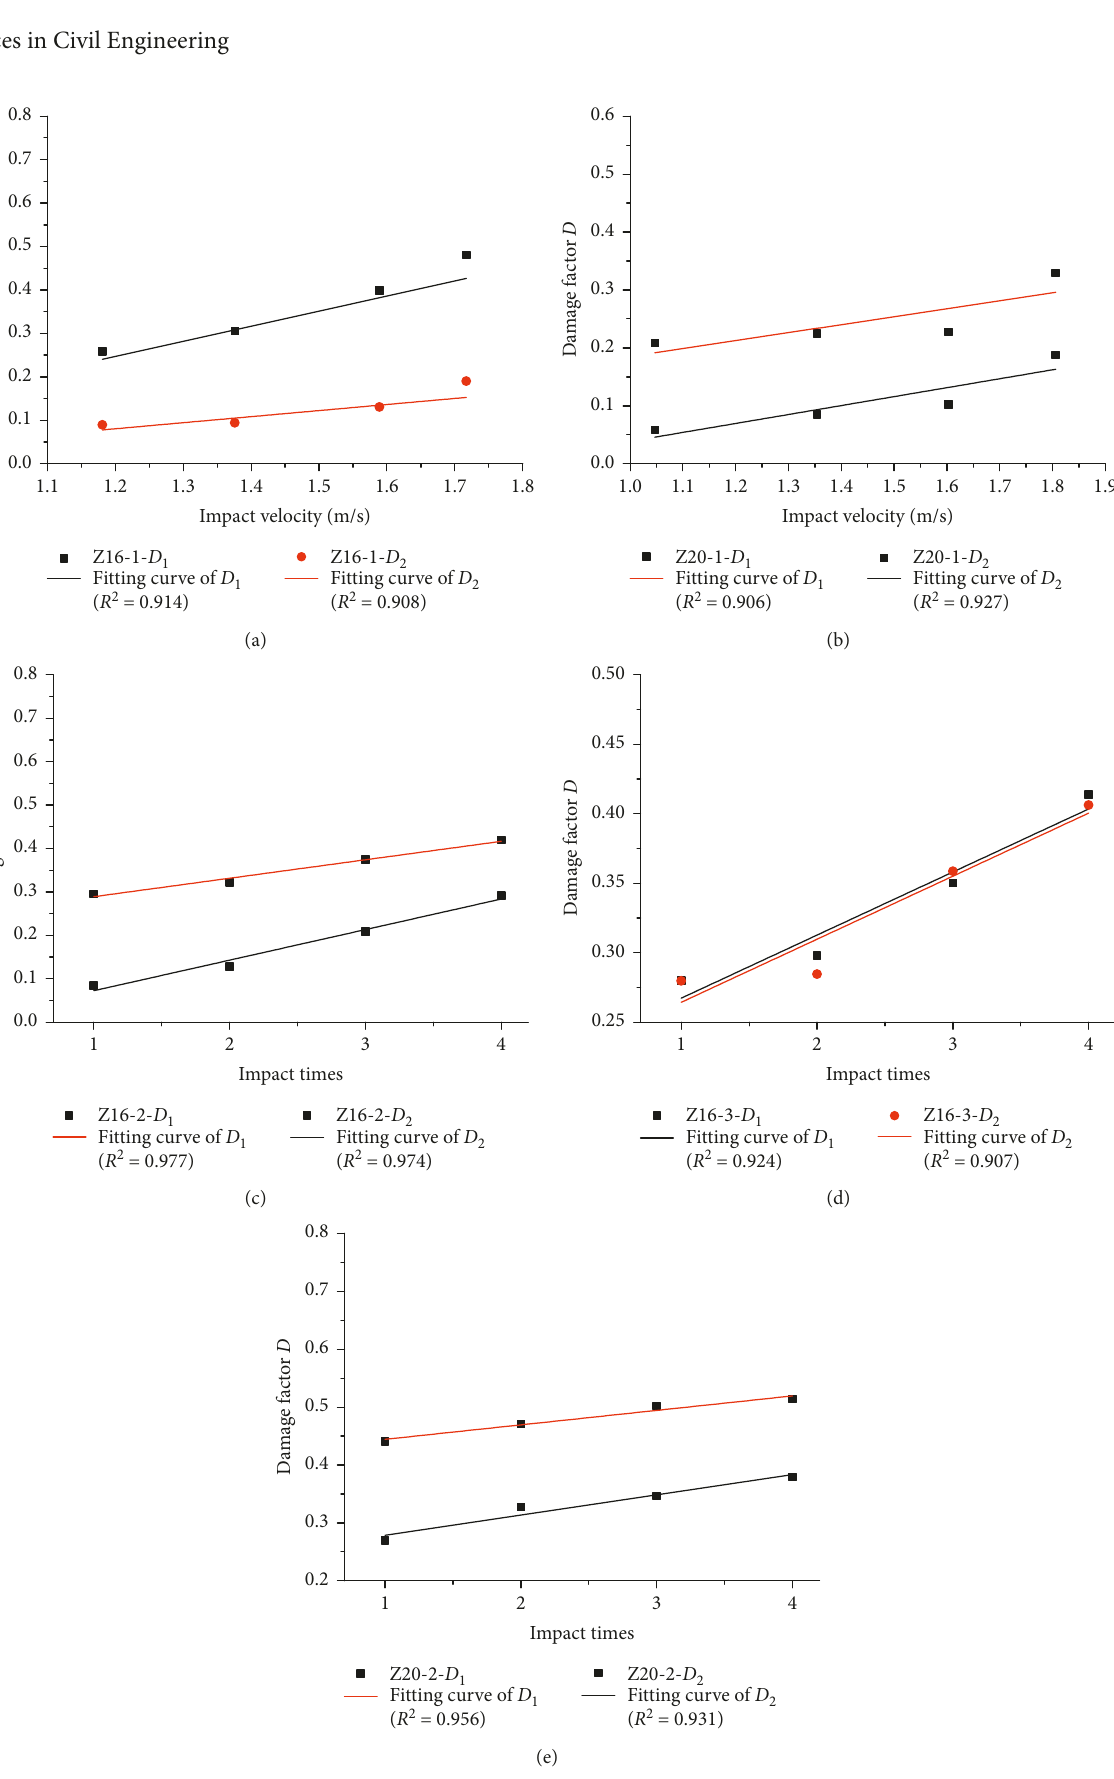
Figure 16: Comparative fitting curves for the modal frequency damage factors and ultrasonic velocity damage factors. (a) Comparative fitting curve of Z16-1, (b) comparative fitting curve of Z20-1, (c) comparative fitting curve of Z16-2, (d) comparative fitting curve of Z16-3, and (e) comparative fitting curve of